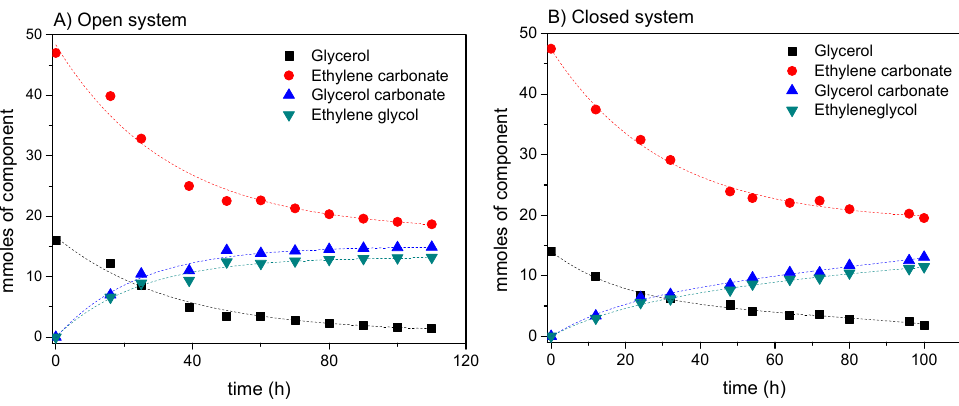
Figure 5. Evolution of the presence of reactants and products in the reaction mixture of reaction 1 for ( A ) the open system and ( B ) the closed system. Conditions: T = 60 °C ; EC:Gly = 3:1; enzyme load: 3% w / w ; solvent: tert-butanol (30% v / v ) agitation speed: 400 rpm.